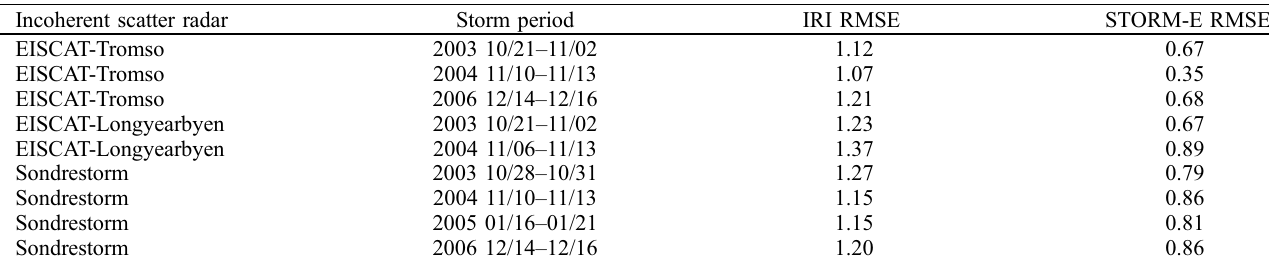
Table 2. Storm-to-quiet electron density ratios in the auroral E -region. Incoherent scatter